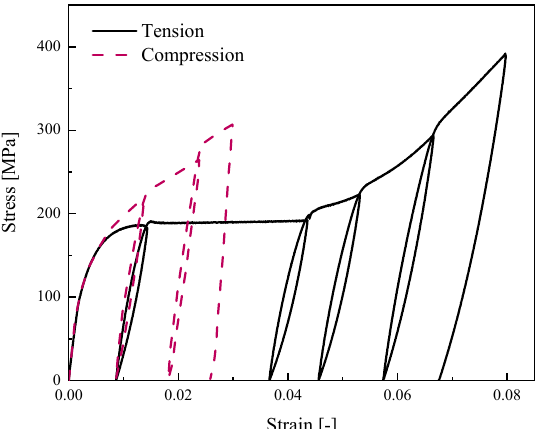
Figure 15. Hysteric tensile and compression tests for martensite SMA beam at room temperature. Table 5. Material properties extracted from experimental tests.